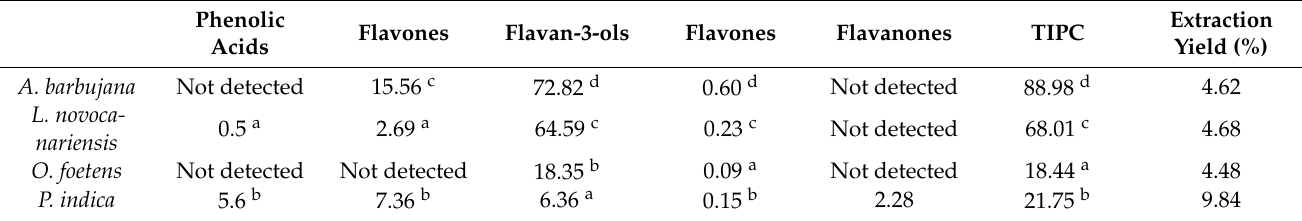
Table 1. Total individual phenolic content (TIPC) (mg g − 1 dry extract) of Lauraceae leaf methanolic extracts determined by HPLC-DAD (data from